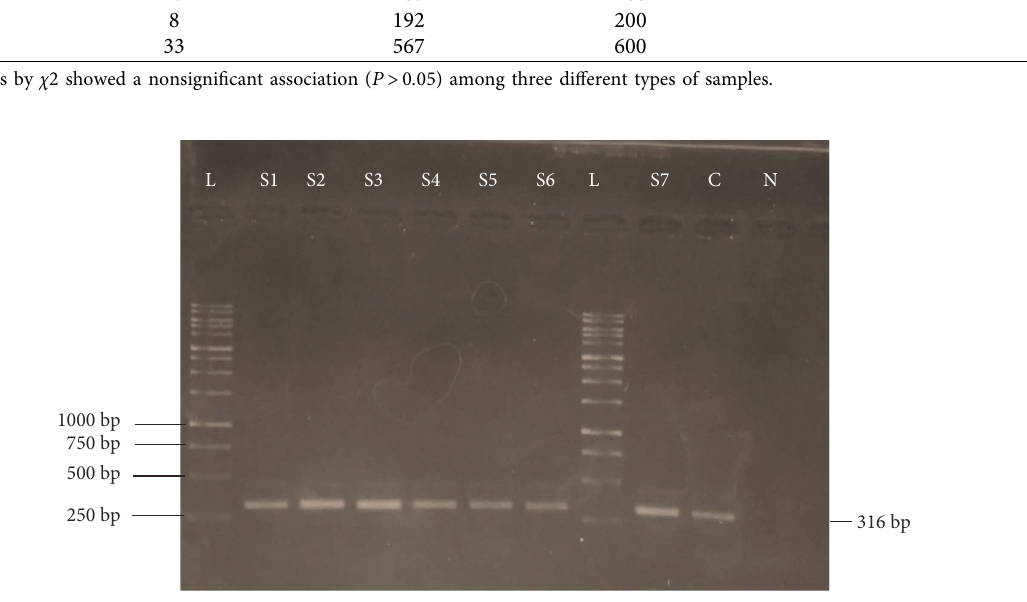
Figure 2: PCR result of Mycoplasma capricolum subsp. capripneunomiae with an amplicon size of 316 in samples collected from goats.